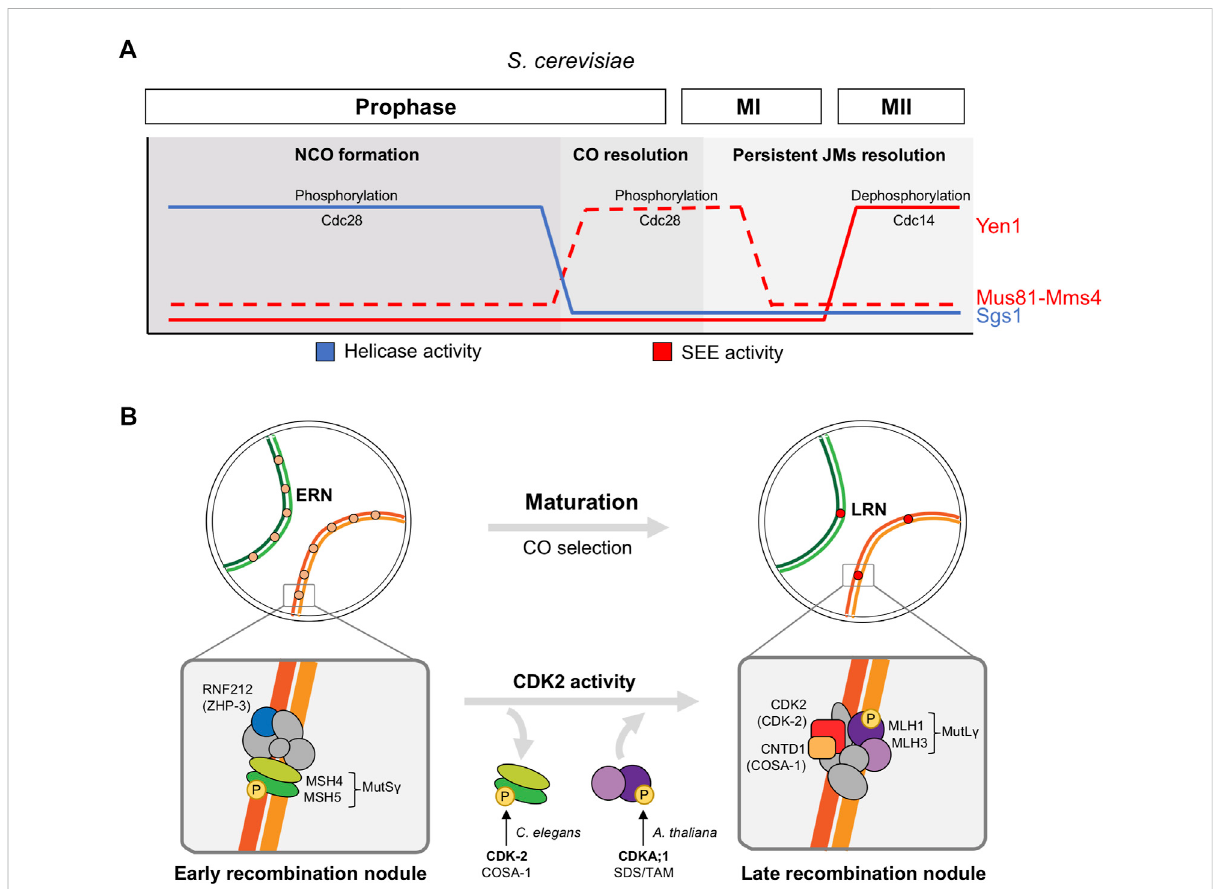
FIGURE 3 CDK regulation of recombinational repair in meiosis. (A) Role of CDK (Cdc28) in the sequential regulation of helicase and structure-selective endonuclease (SEE) activities in S. cerevisiae . Low Cdc28 activity activates the RecQ-family DNA helicase Sgs1 during early prophase to promote NCO formation, high levels of Cdc28 activity at meiosis I entry activates Mus81-Mms4 SSE to implement CO resolution prior to chromosome segregations, and Yen1 SSE activation by the Cdc14 phosphatase at meiosis II releases its earlier Cdc28-dependent inhibition to process persistent unresolved joint molecules (JMs). (B) Role of CDK2 in the maturation of early recombination nodules (ERN) and CO selection (late recombination nodules, LRN) in higher eukaryotes. Protein complexes are only illustrative and they do not represent protein-protein interaction nor stoichiometry.Onlykeyproteinsconservedinseveralorganismsarehighlighted:MutS γ complexMSH4-MSH5,RNF212(ZHP-3in C.elegans ),MutL γ complex MLH1-MLH3, CDK2 (CDK-2 in C. elegans , CDKA;1 in A. thaliana ), CNTD1 (COSA-1 in C. elegans ). These proteins are keyfactors that